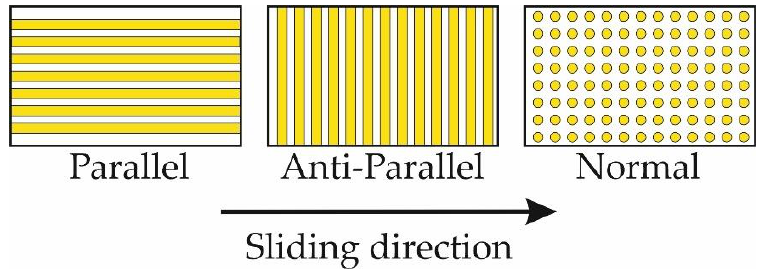
Figure 1. Schematic view of fiber orientation within EACs samples, respecting the sliding direction.